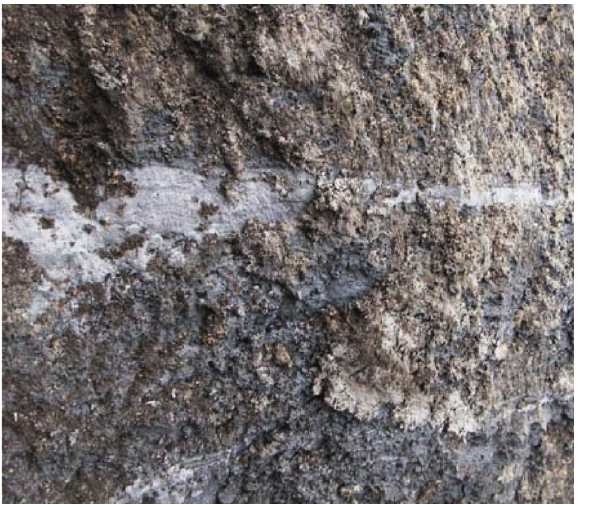
Fig. 2. Study area in Grinsted, north Jutland